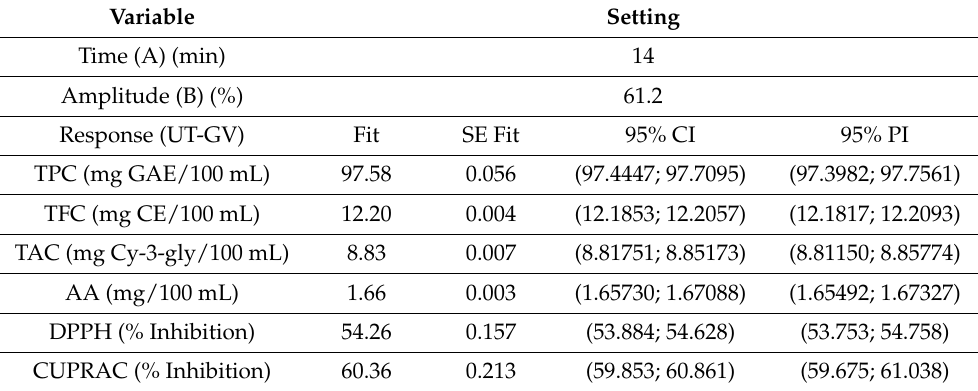
Table 4. Maximum optimization values according to